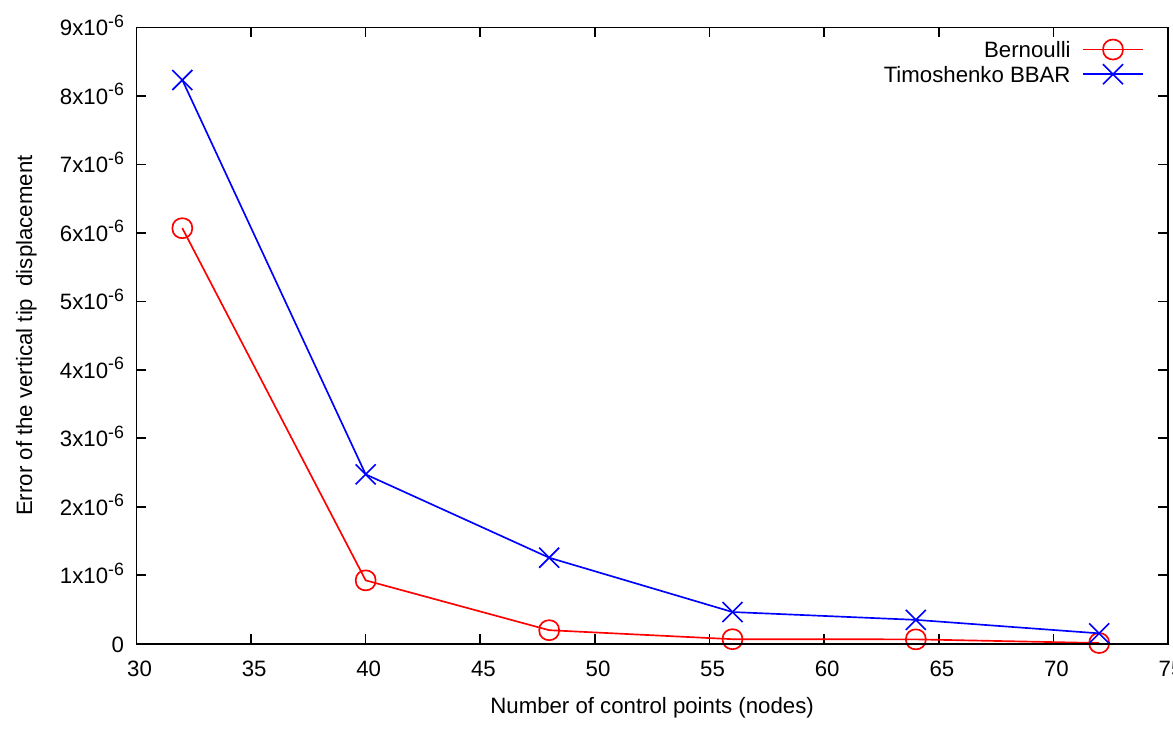
Figure 7. Comparison of covergence of Timoshenko beam element and Bernoulli beam element. The vertical axis corresponds to the erro of vertical tip displacement w , the horizontal axis corresponds to the number of nodes (control points). The error is calculated with respect to the reference solution of particular beam